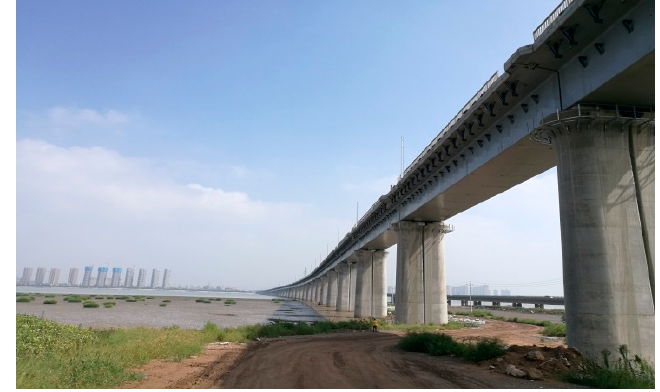
Figure 14. Jiaozhou Bay sea-crossing railway bridge (completed). Table 11. Parameters used in the revised DuraCrete model in the marine section.